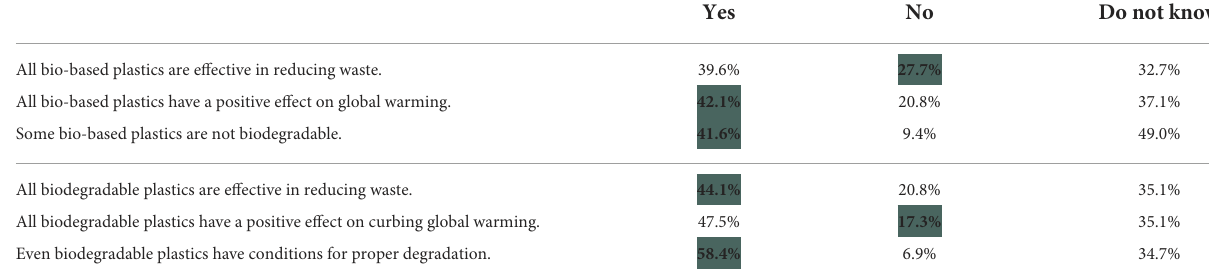
TABLE 1 Targeted questions regarding the knowledge of bioplastics.